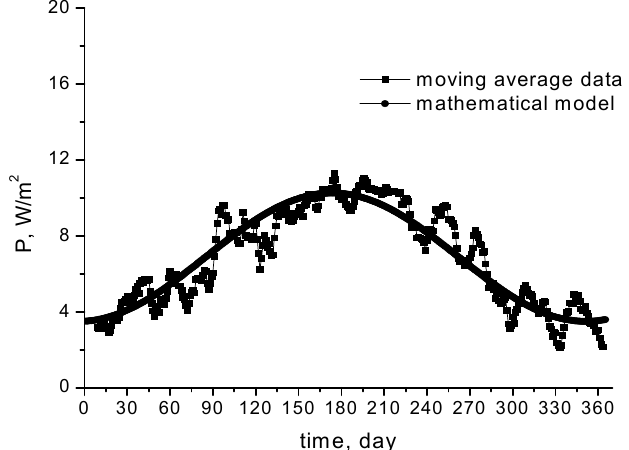
Figure 4. Relationship between moving average data and the mathematical model.